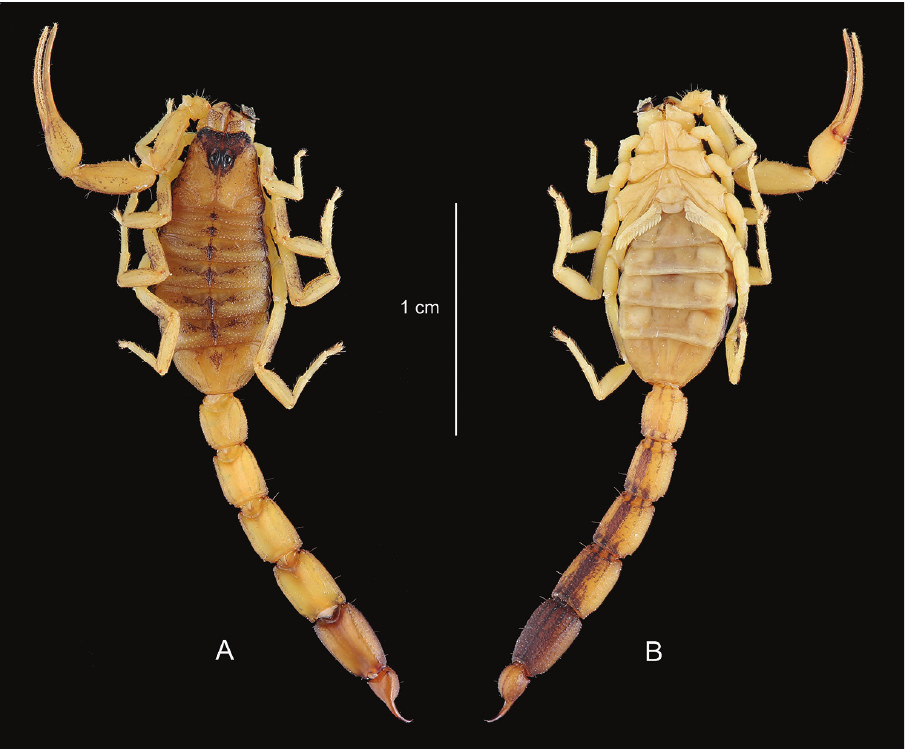
Figure 4. Physoctonus amazonicus sp. n., Habitus of female holotype, dorsal and ventral aspects. stridulatory apparatus; fulcra moderately marked; basal middle lamellae not dilated in female; basal piece strongly marked. Sternites with short linear spiracles. Telson with a globular vesicle; aculeus long and strongly curved, with a vestigial spinoid subaculear tooth. Trichobothrial pattern of type A- α (alpha) – orthobothriotaxic (Vachon 1974, 1975) Tibial spurs absent; pedal spurs